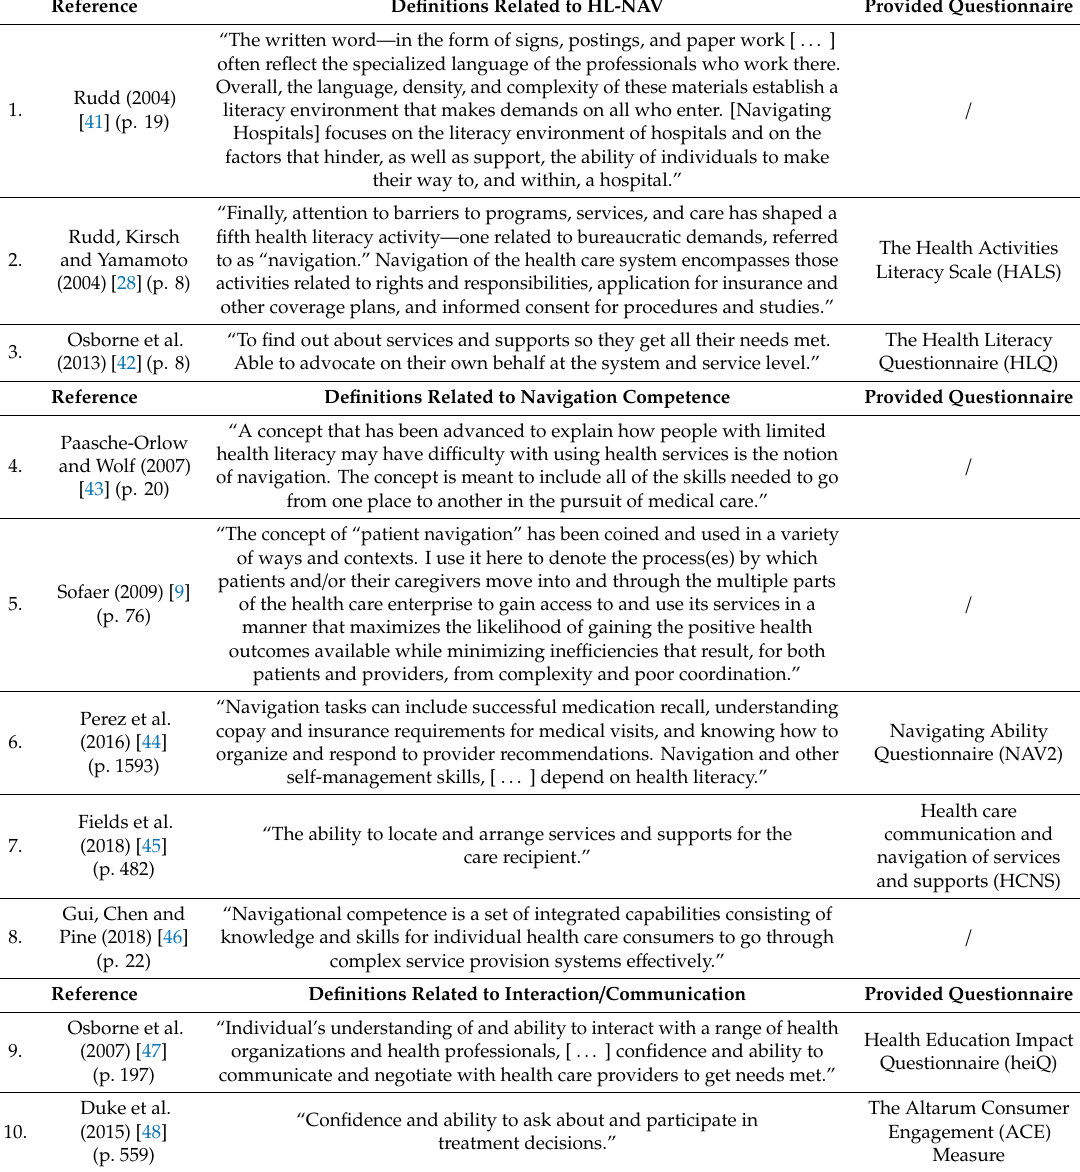
Table 1. Literature research